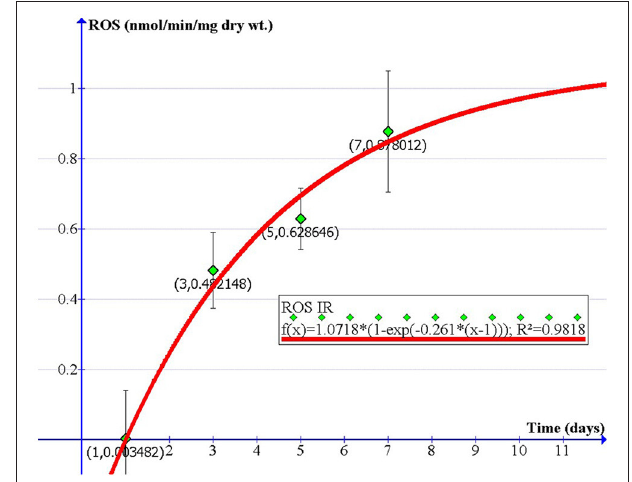
FIGURE 6 | A physical model describing the rate of extracellular ROS production vs. time in diaphragm after exposure to 10-Gy IR (nmol/min/mg dry